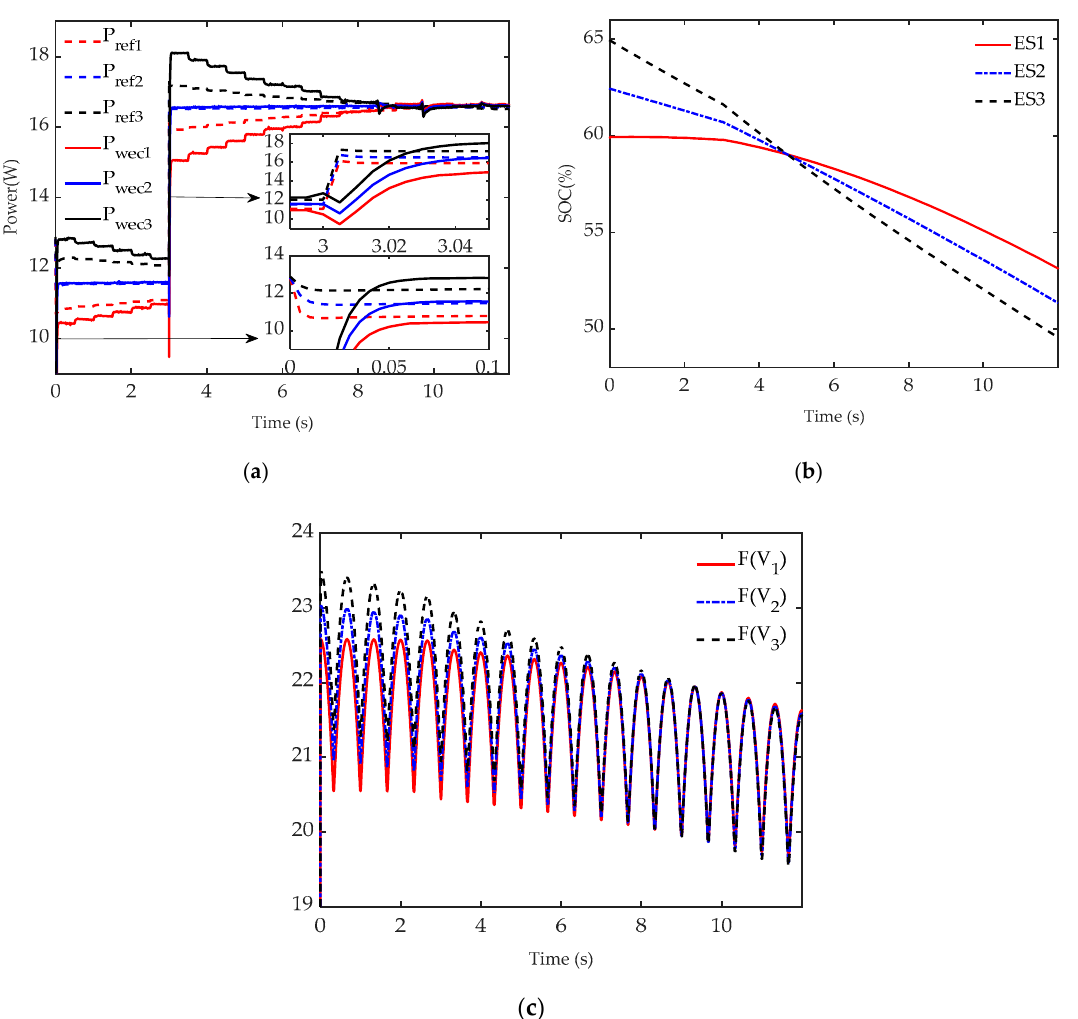
Figure 12. Performance of WECs with different initial WHD output and SOC: ( a ) Reference output powers and actual output powers of each WEC; ( b ) SOC curve; ( c ) WEC integral energy state ( F ( V i ) ).